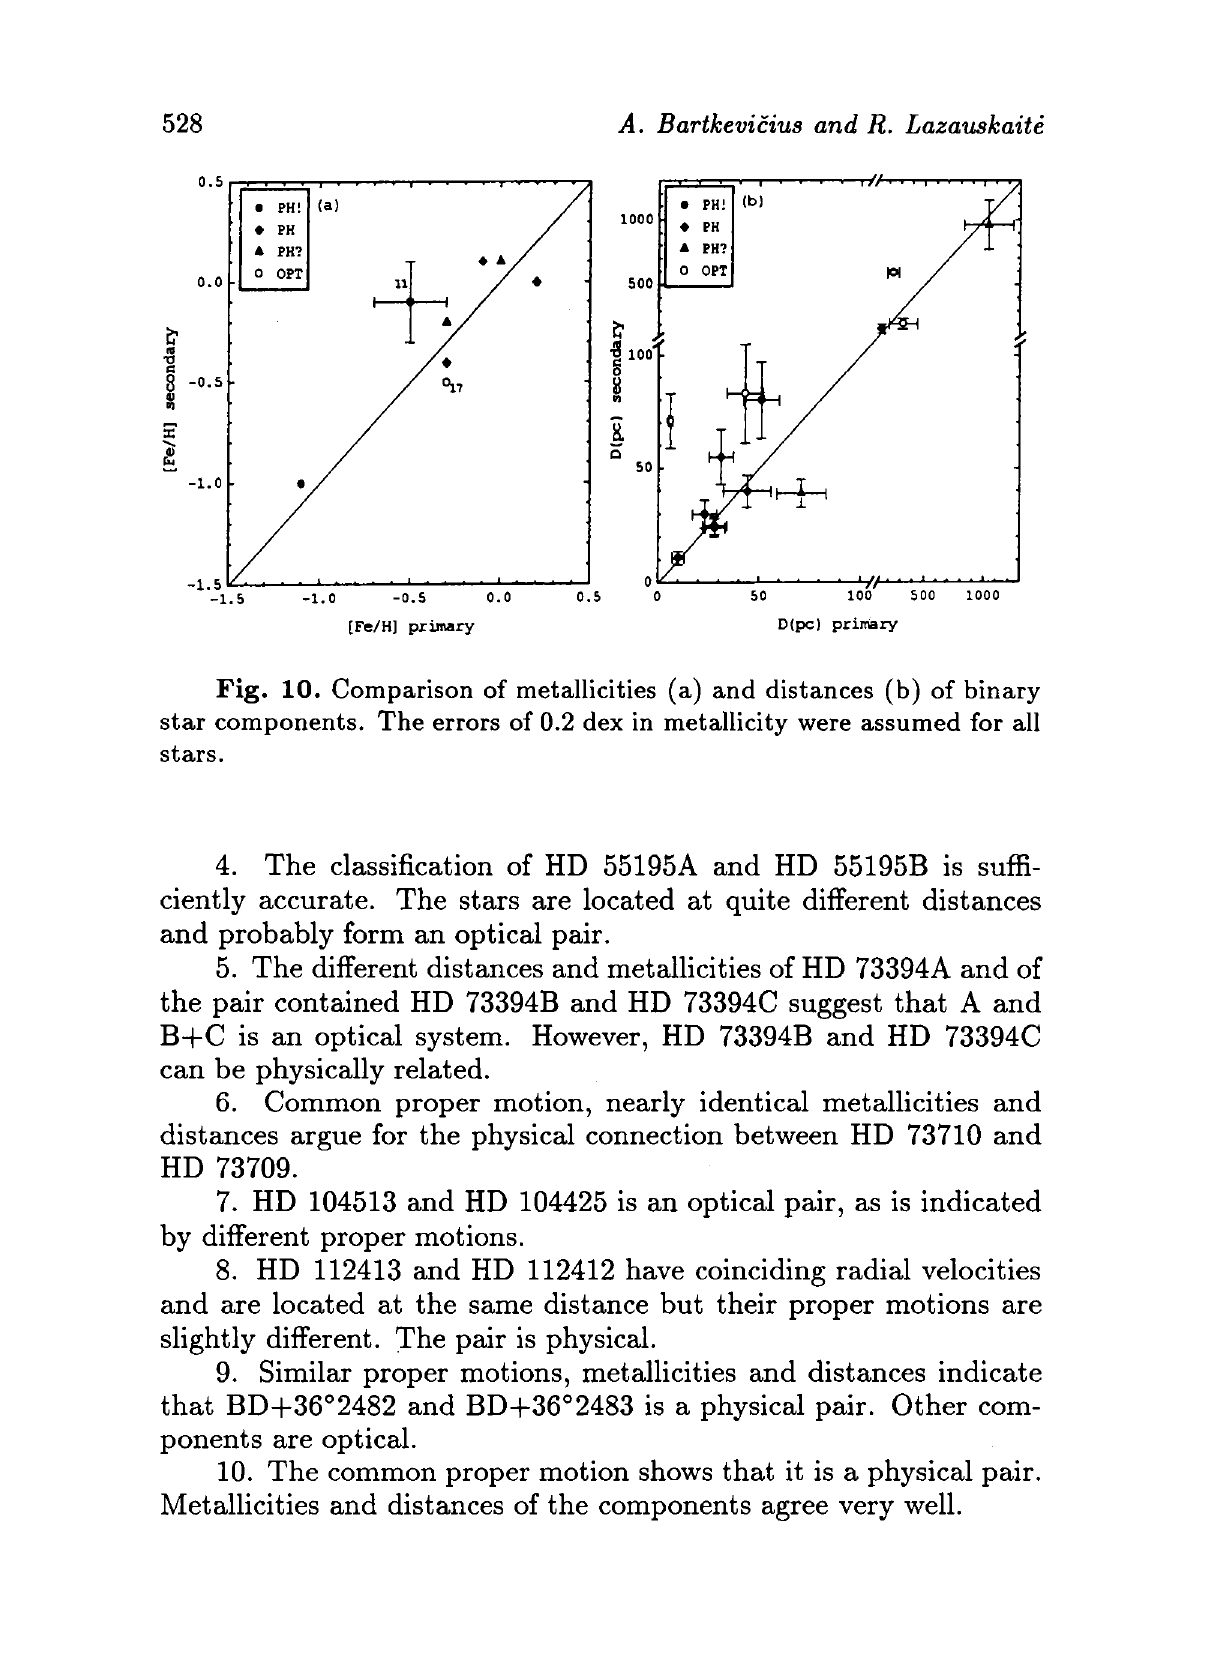
Fig. 10. Comparison of metallicities (a) and distances (b) of binary star components. The errors of 0.2 dex in metallicity were assumed for all